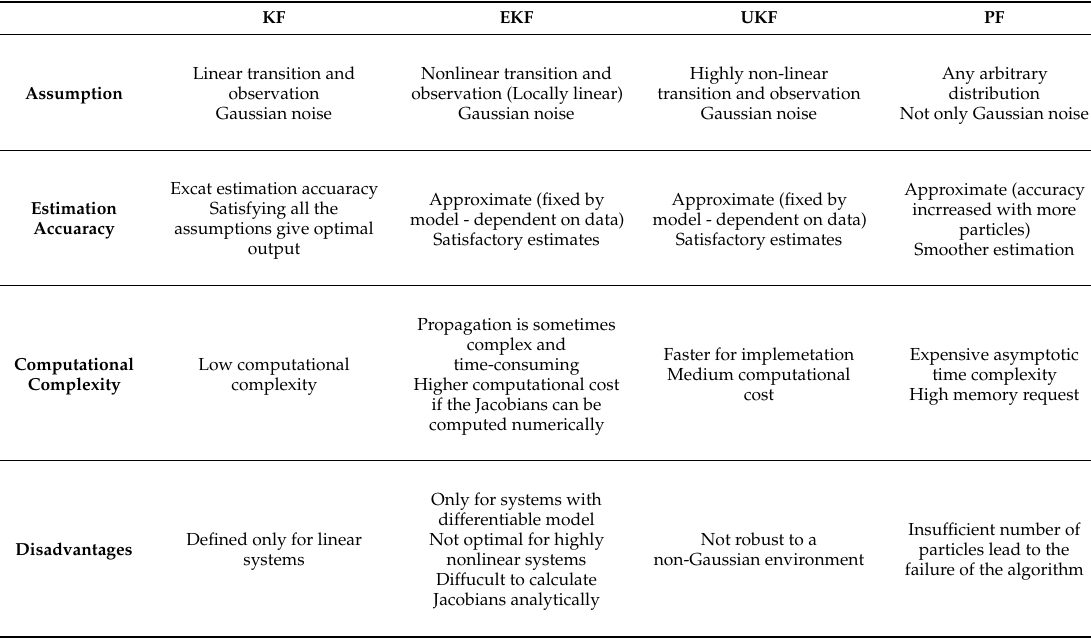
Table 3. Overview of different KF based filtration methods